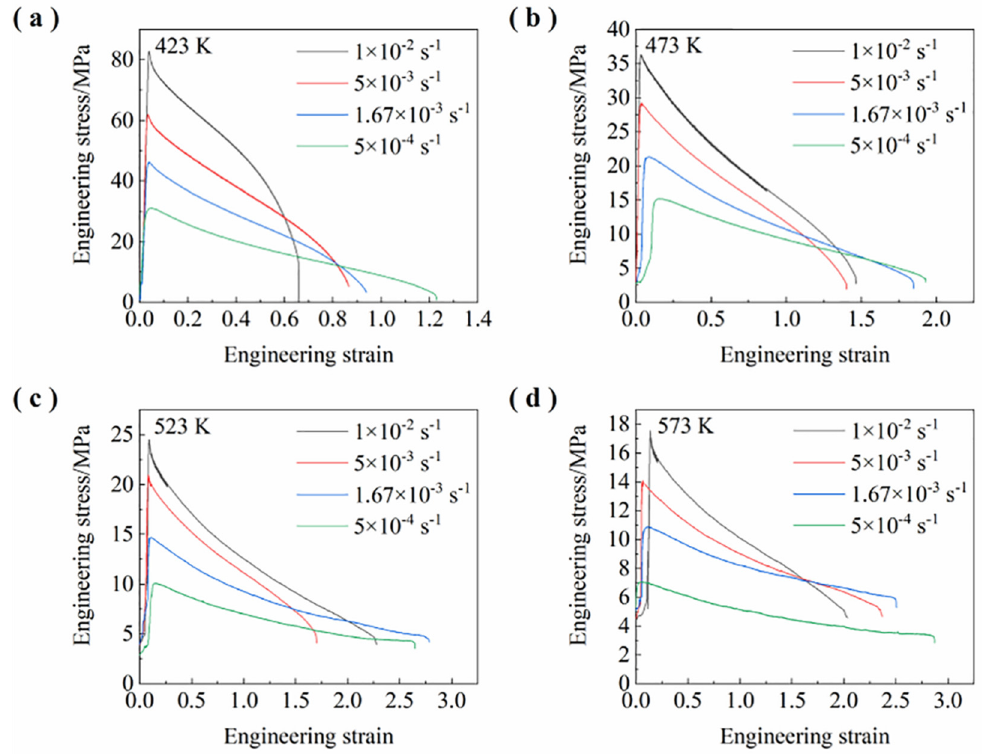
Figure 3. Engineering stress–strain curves of this alloy at different temperatures and strain rates: ( a ) 423 K, ( b ) 473 K, ( c ) 523 K, and ( d ) 573 K.